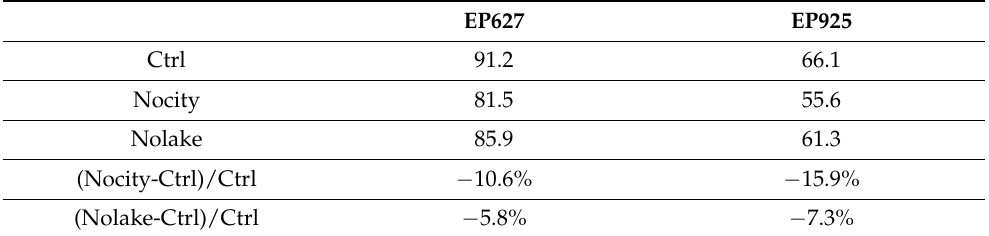
Table 3. A comparison of the simulated daily precipitation (units: mm) for the control and two sensitive runs and the relative biases in the sensitive runs compared to the control run for two